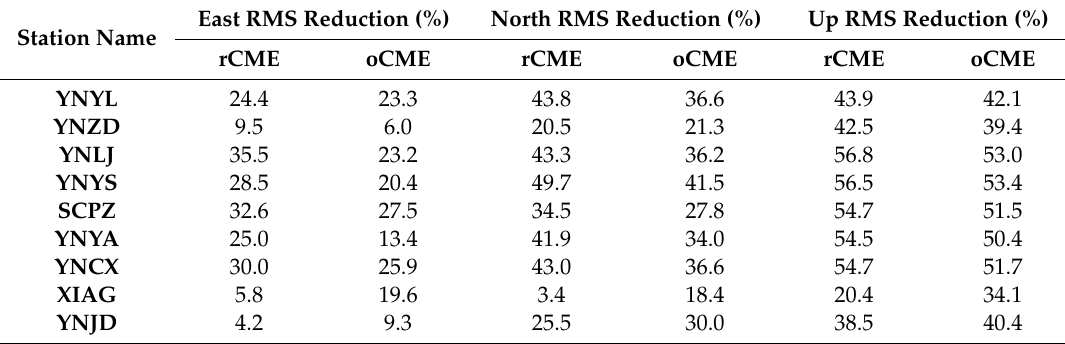
Table 3. Root mean square (RMS) reductions of CME corrections for GPS time